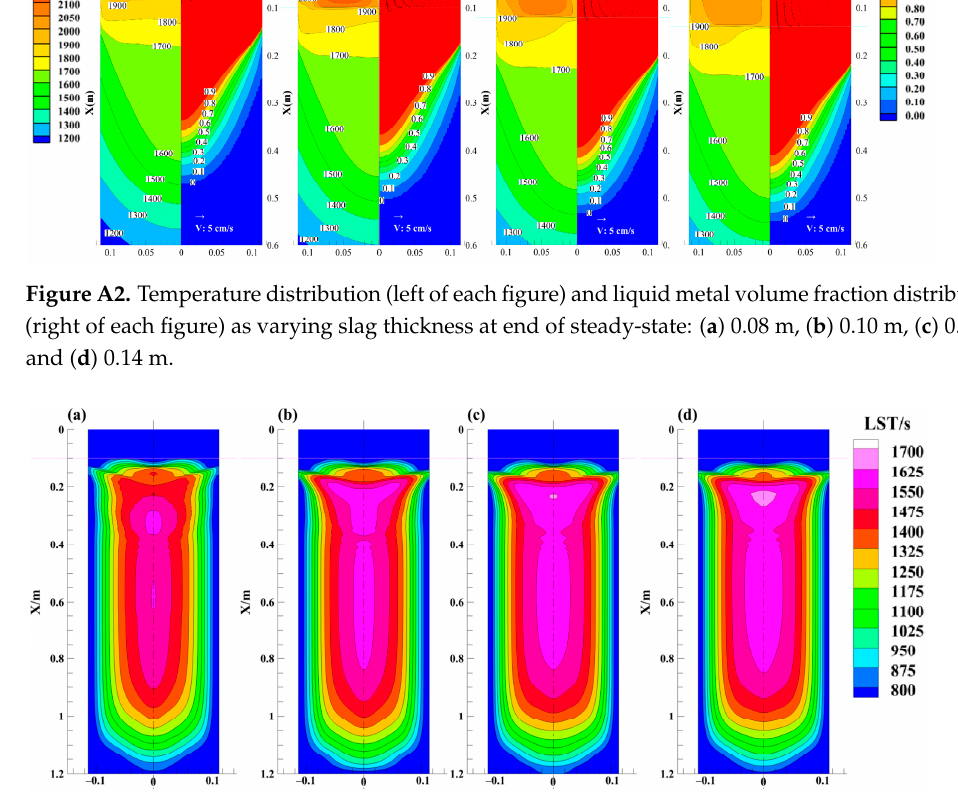
Figure A4. Distribution of PDAS with varying filling ratio: ( a ) 0.16, ( b ) 0.23, ( c ) 0.33 and ( d ) 0.43.